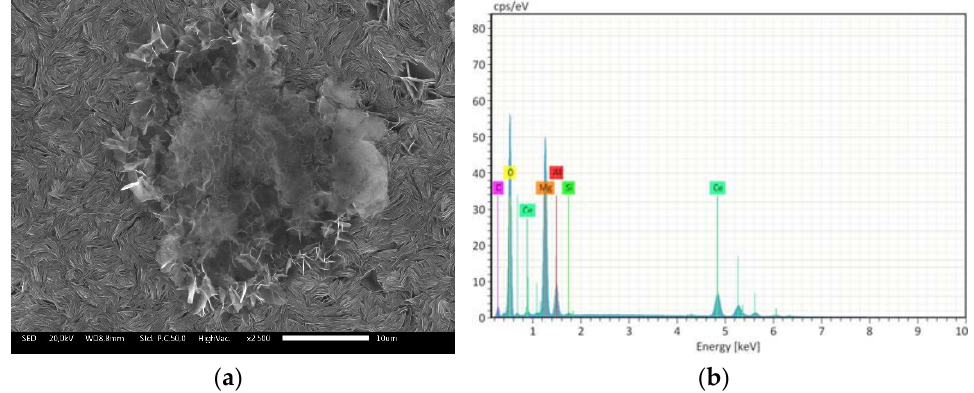
Figure 7. Ce-rich agglomerate on LDH surface ( a ) and the corresponding EDS analysis ( b ).